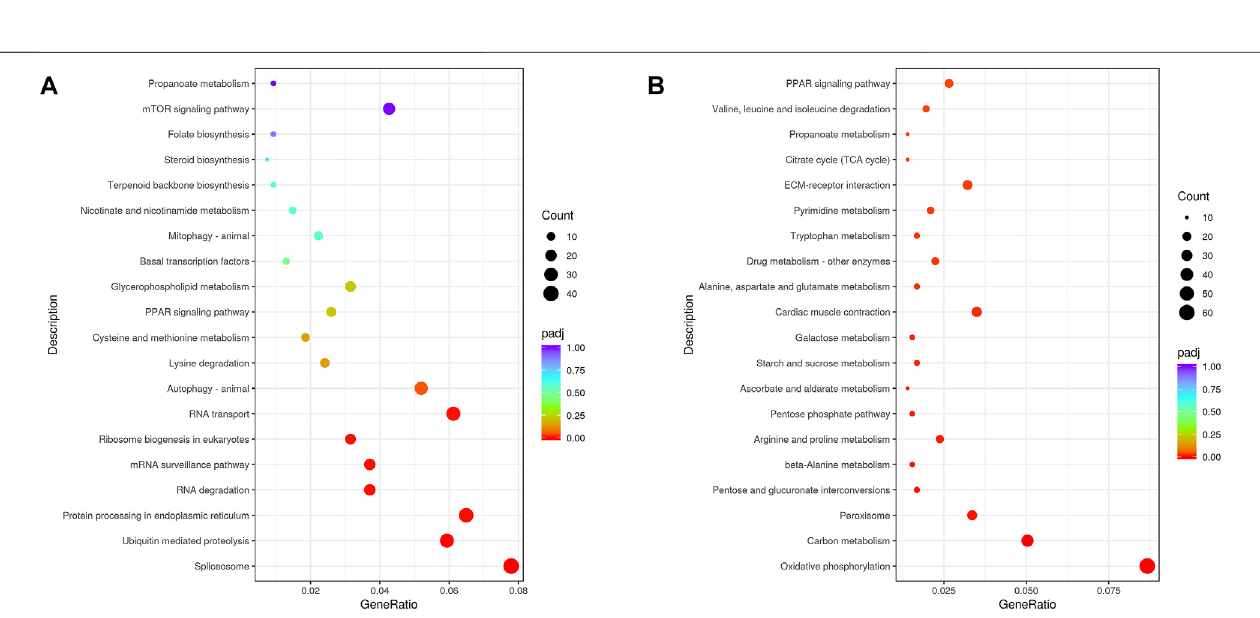
FIGURE 2 | KEGG pathway classi fi cations for upregulated (A) and downregulated (B) DEGs.